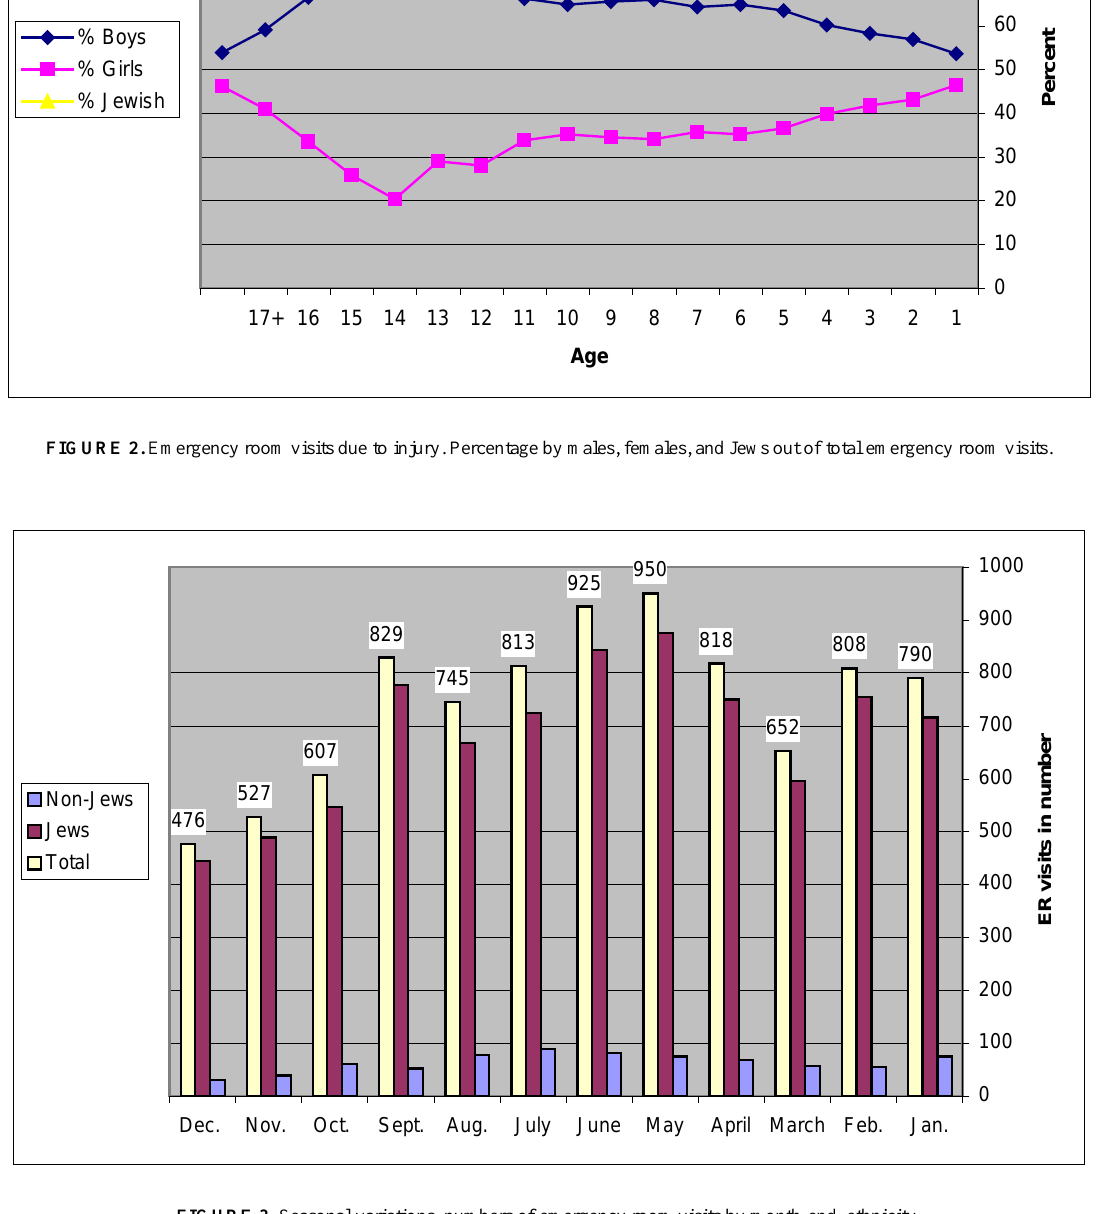
compared with injuries of the same types throughout the entire year. During Rosh Hashanah, Yom Kippur, and Succoth, bicycle, skateboard, and roller-blade injuries were 2.3, 5.1, and 2.2% higher, respectively, compared with statistics throughout the year. One may observe that the highest increase was on Yom Kippur (20% of injuries on Yom Kippur were these types